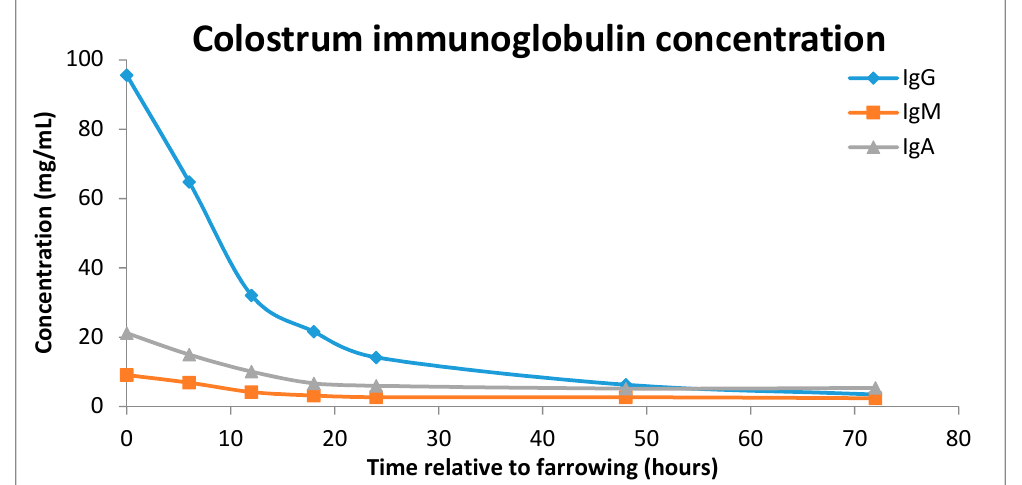
Figure 2. Concentration of immunoglobulins (IgG blue line, IgM, orange line and IgA, purple line) in sow colostrum over a 72 h period post farrowing (adapted from Klobasa, Werhahn and Butler [7]).